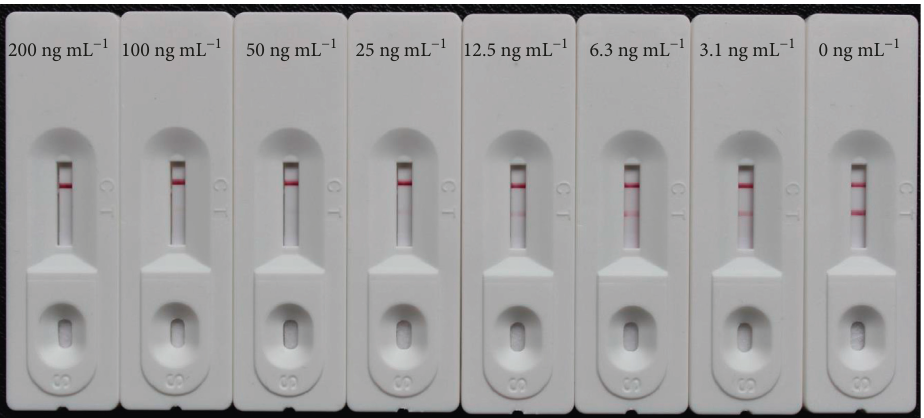
Figure 3: CGIC strips showing color changes corresponding to the concentrations of rhein. The cutoff value for rhein was 50ng mL − 1 .